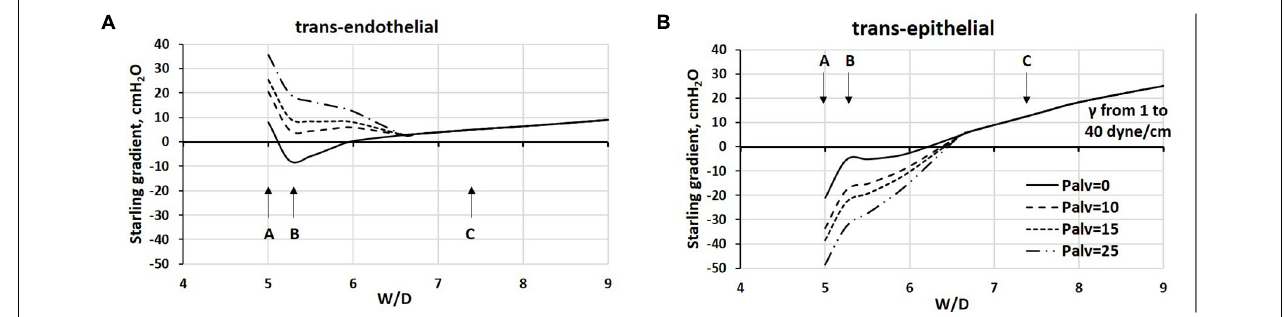
FIGURE 9 | Estimated Starling pressure gradients at (A) endothelial and (B) epithelial levels on increasing alveolar pressure by up to 25 cmH 2 O, and on varying W/D from 5 to 9. Points A, B, and C refer to those in Figure 4